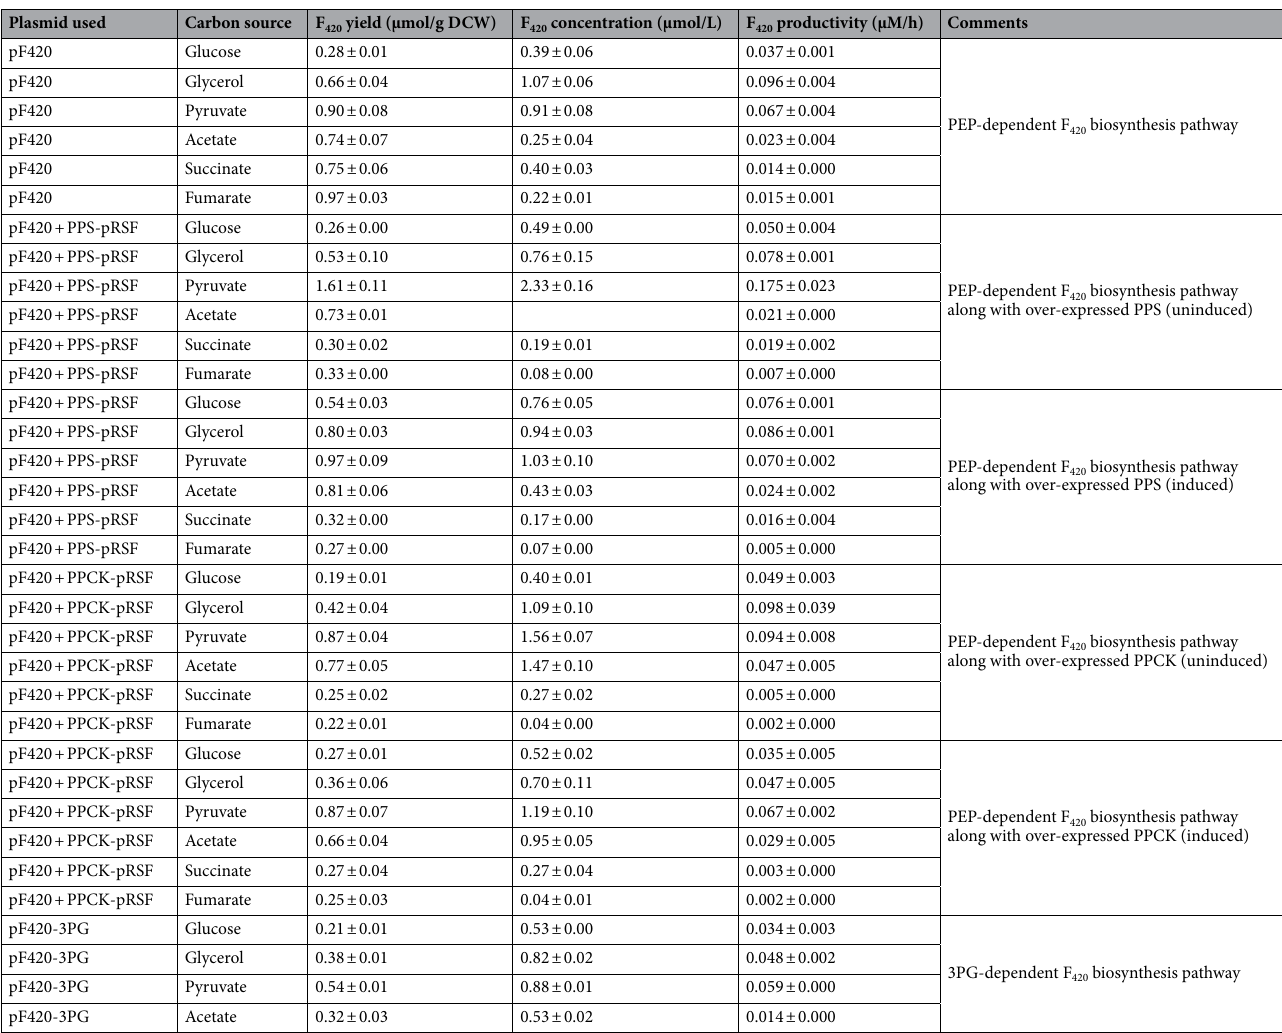
Table 1. Summary of the results obtained for engineered E. coli producing PEP-dependent or 3PG-dependent F 420 using different carbon sources with and without overexpression of either PPS or